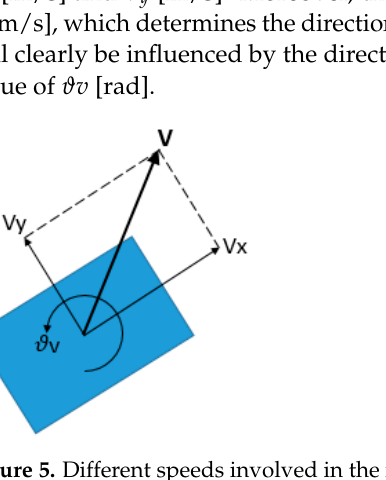
Figure 4. Pseudocode of Lyapunov function computation on the agent.